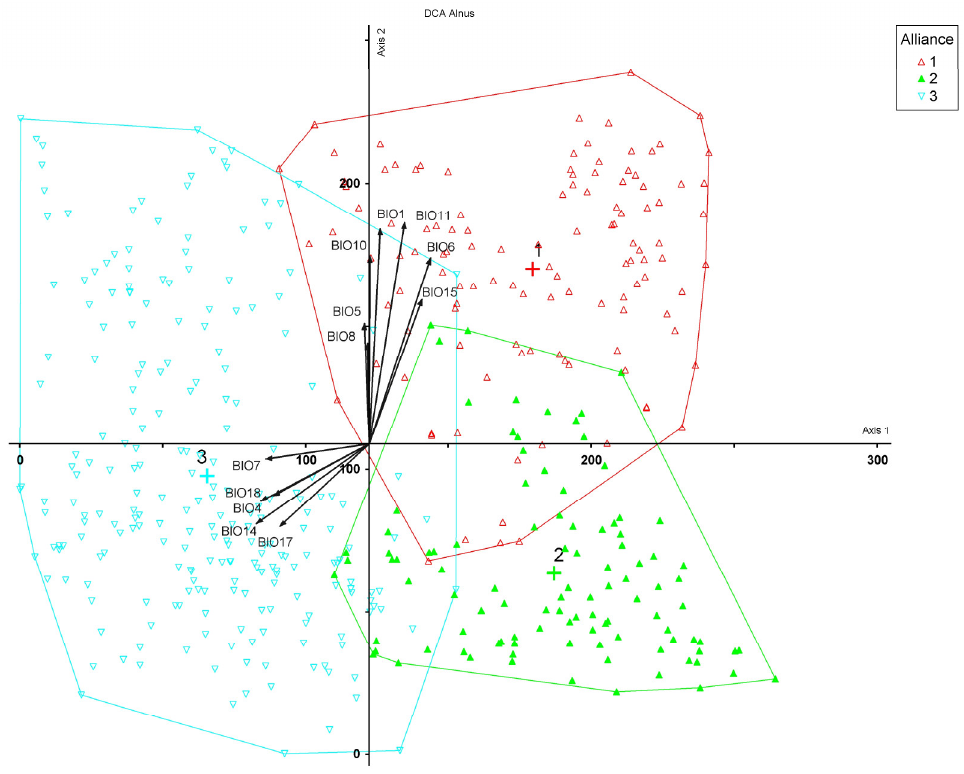
Figure 3. DCA of the sub-alliance and alliance. Total variance (‘inertia’) in the species data: 4.49. The r squared values of axes 1 and 2 are, respectively, 0.32 and 0.24. Alliance and sub-alliances: 1. Hyperico hircini-Alnenion glutinosae ; 2. Struthioptero-Alnenion glutinosae ; 3. Ligustro vulgaris-Alnion glutinosae . Bioclimatic variables: BIO1 = Annual Mean Temperature; BIO4 = Temperature Seasonality; BIO5 = Max Temperature of Warmest Month; BIO6 = Min Temperature of Coldest Month; BIO7 = Tem-perature Annual Range; BIO8: Mean Temperature of Wettest Quarter BIO10 = Mean Temperature of Warmest Quarter; BIO11 = Mean Temperature of Coldest Quarter; BIO14 = Precipitation of Driest Month; BIO15 = Precipitation Seasonality; BIO17 = Precipitation of Driest Quarter; BIO18 = Precipitation of Warmest Quarter.